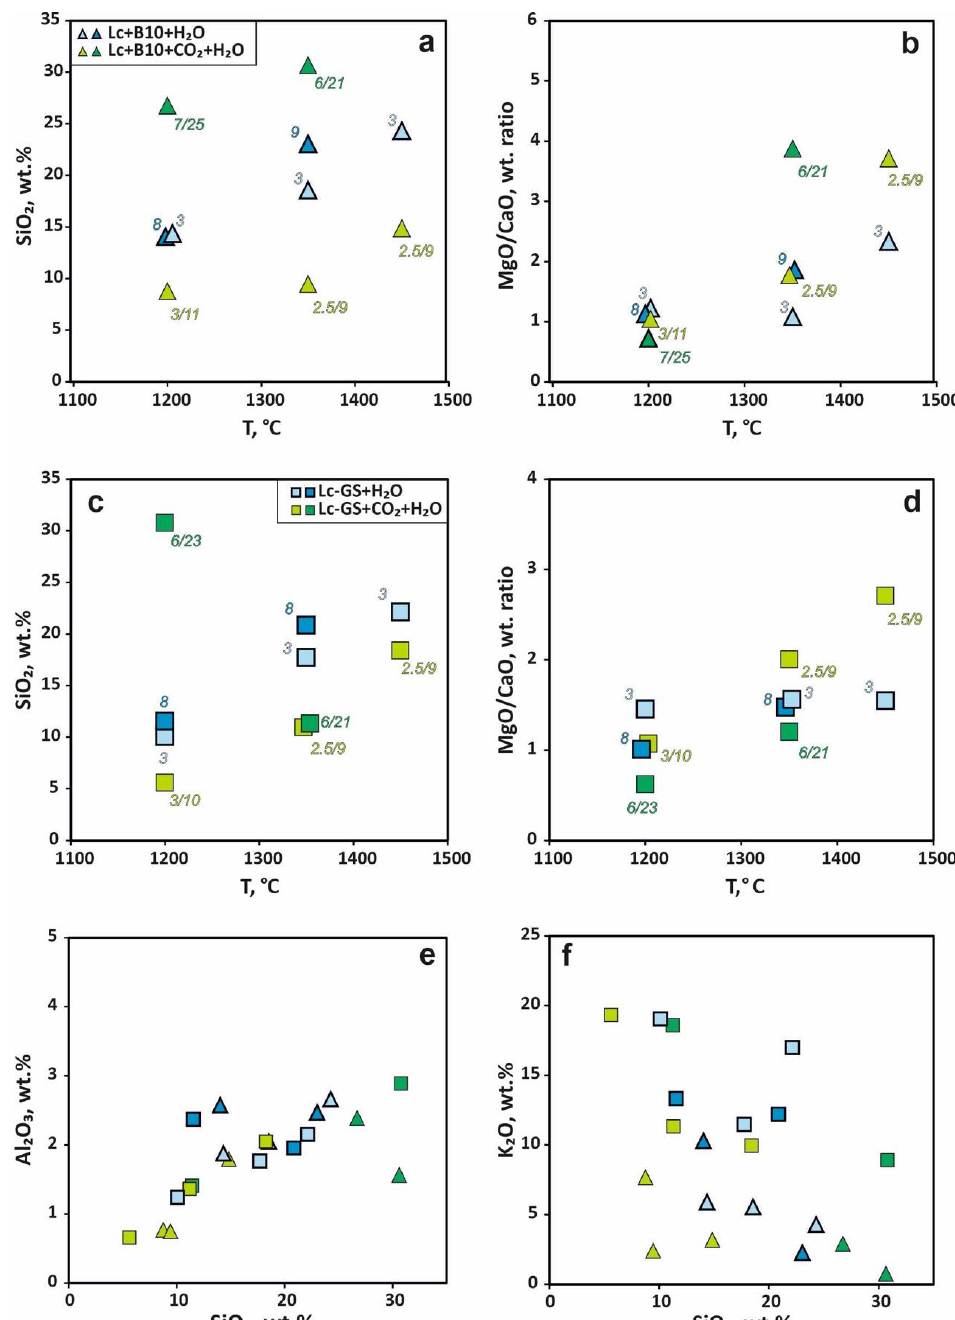
Figure 4. Major element compositions of experimental melts (on H 2 O-free basis). ( a , b ): temperature- dependent SiO 2 contents ( a ) and MgO/CaO weight ratio ( b ) in Lc-B10 samples; ( c , d ): temperature- dependent SiO 2 contents ( c ) and MgO/CaO weight ratio ( d ) in Lc-GS samples; ( e ): Al 2 O 3 vs. SiO 2 contents in Lc-B10 and Lc-GS samples; ( f ): K 2 O vs. SiO 2 contents in Lc-B10 and Lc-GS samples; Lc- B10-CO 2 -H 2 O = lherzolite – carbonatite B10 samples with added CO 2 and H 2 O; Lc-B10-H 2 O = lher- zolite – carbonatite B10 samples with added H 2 O; Lc-GS-CO 2 -H 2 O = lherzolite – GS samples with added CO 2 and H 2 O (CO 2 /H 2 O content, wt%); Lc-GS-H 2 O = lherzolite – GS samples with added H 2 O (H 2 O content, wt%).